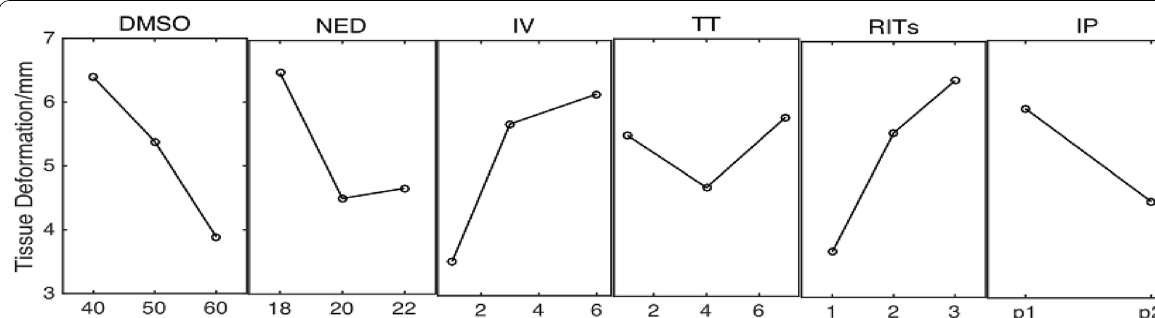
Figure 10 Main effect plot of orthogonal factor on phantom deformations